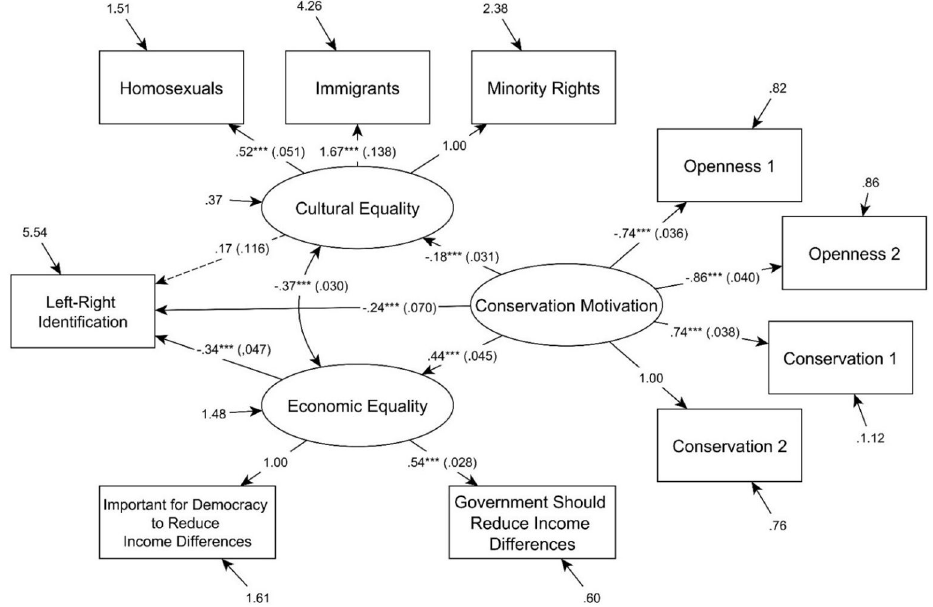
Figure 3. Pathway Model Explaining Left-Right Ideological Preferences – CEE Countries. Note. Unstandardized regression weights are followed by standard errors in parentheses. Unstandardized residual variances are displayed for every variable. ( χ 2 = 509.99; df = 30; CFI = .902; RMSEA = .045). * p < .05. ** p < .01. *** p <